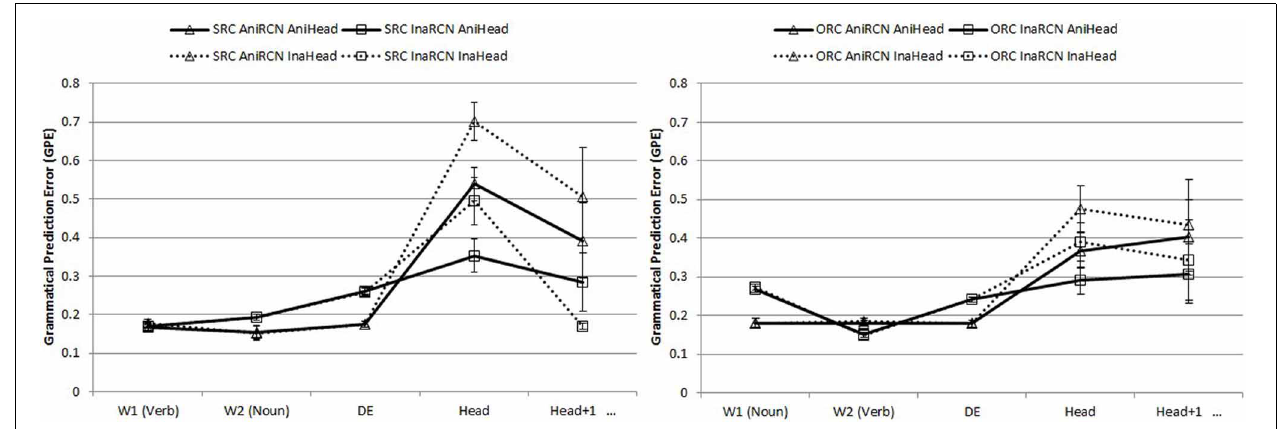
FIGURE 3 | Word-by-word GPEs of subject-modifying SRCs (left panel) and ORCs (right panel) in the critical RC region, the head, and next word after the head.